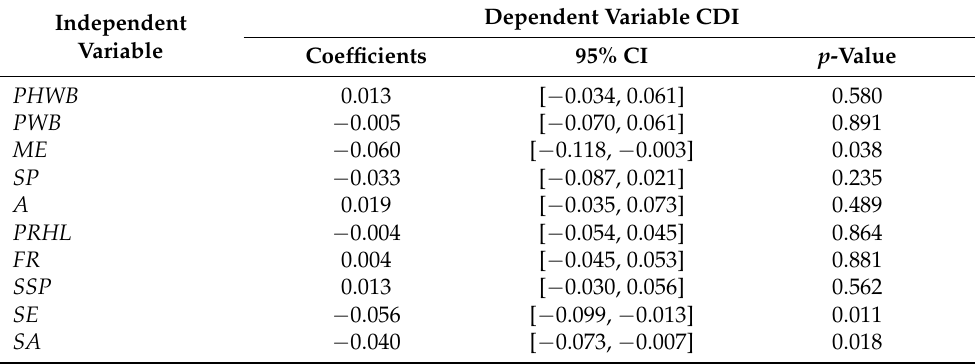
Table 4. Regression coefficients for the dimensions of health-related to the quality of life.